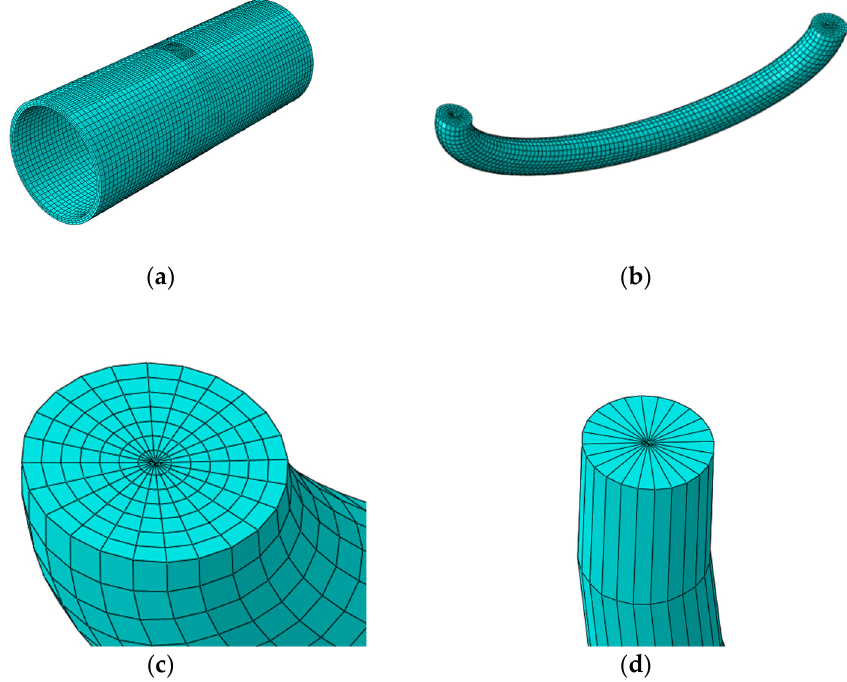
Figure 2. Meshing of the pipe with the inclined internal surface crack:( a ) global view of the cracked pipe; ( b ) equal divisions at the crack front; ( c ) hexahedron elements around the crack front; ( d ) wedge-shaped elements at the crack front.